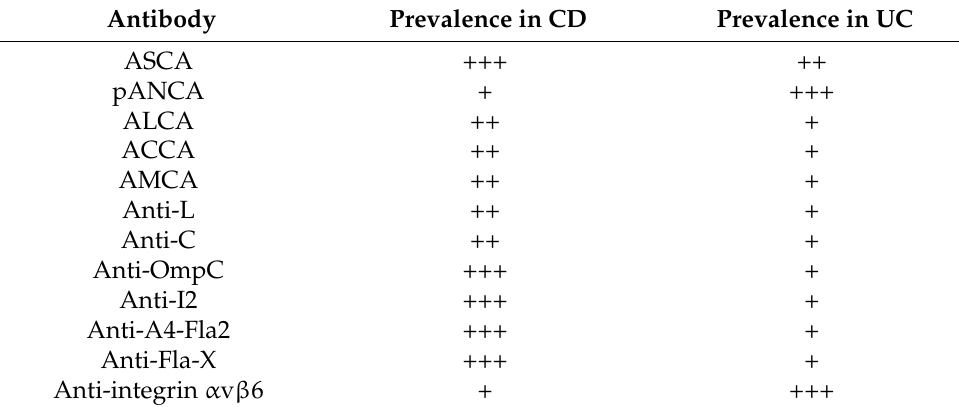
Table 4. Antibodies associated with Ulcerative Colitis and Crohn’s